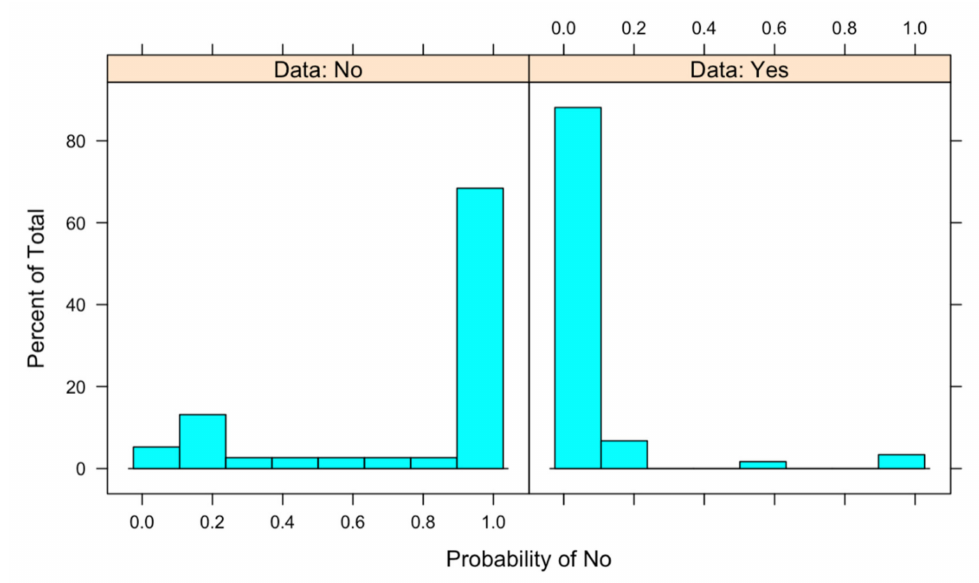
Figure 6. Histogram of probabilities distribution. Radial Basis Neural Network.